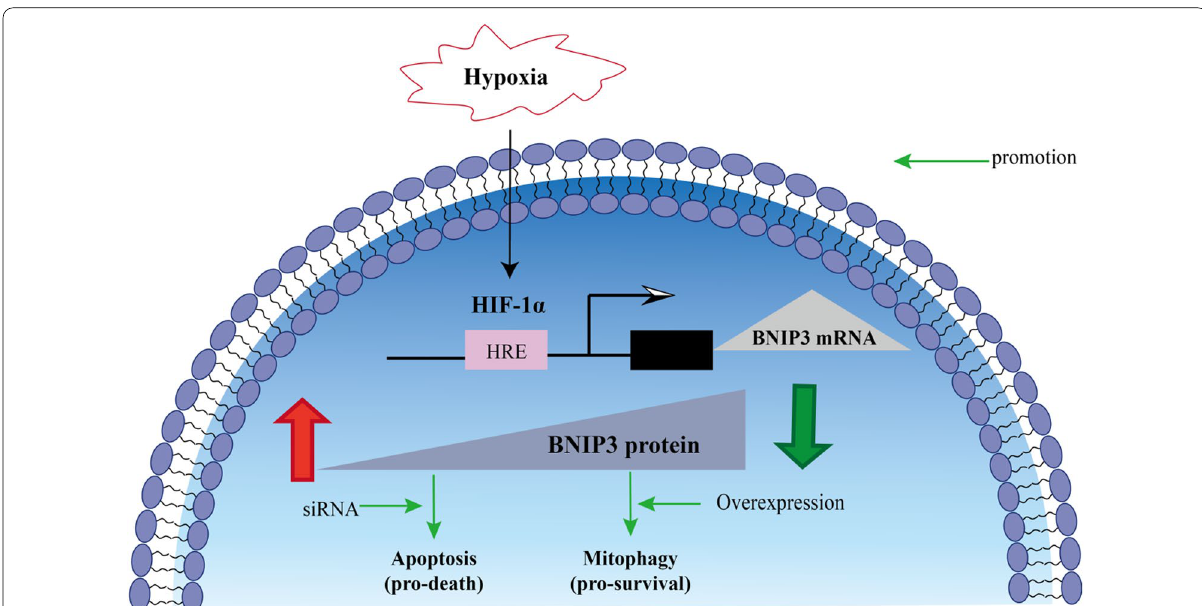
Fig. 7 Under hypoxic conditions, the occurrence of mitophagy and the regulation of BNIP3. Under hypoxia, RA-FLSs mediated mitophagy through high expression of BNIP3 to eliminate excess ROS in cells, maintain redox balance, reduce the occurrence of apoptosis, and promote cell survival. The expression of BNIP3 in OA-FLSs was relatively small, and the mitophagy mediated by it was not enough to eliminate excess ROS in cells, resulting in increased apoptosis and decreased cell